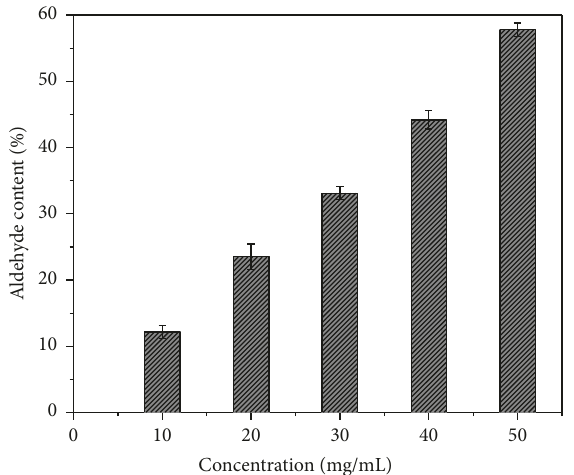
Figure 2: The influence of the concentration of NaIO 4 on the generated content of aldehyde groups in the cellulose